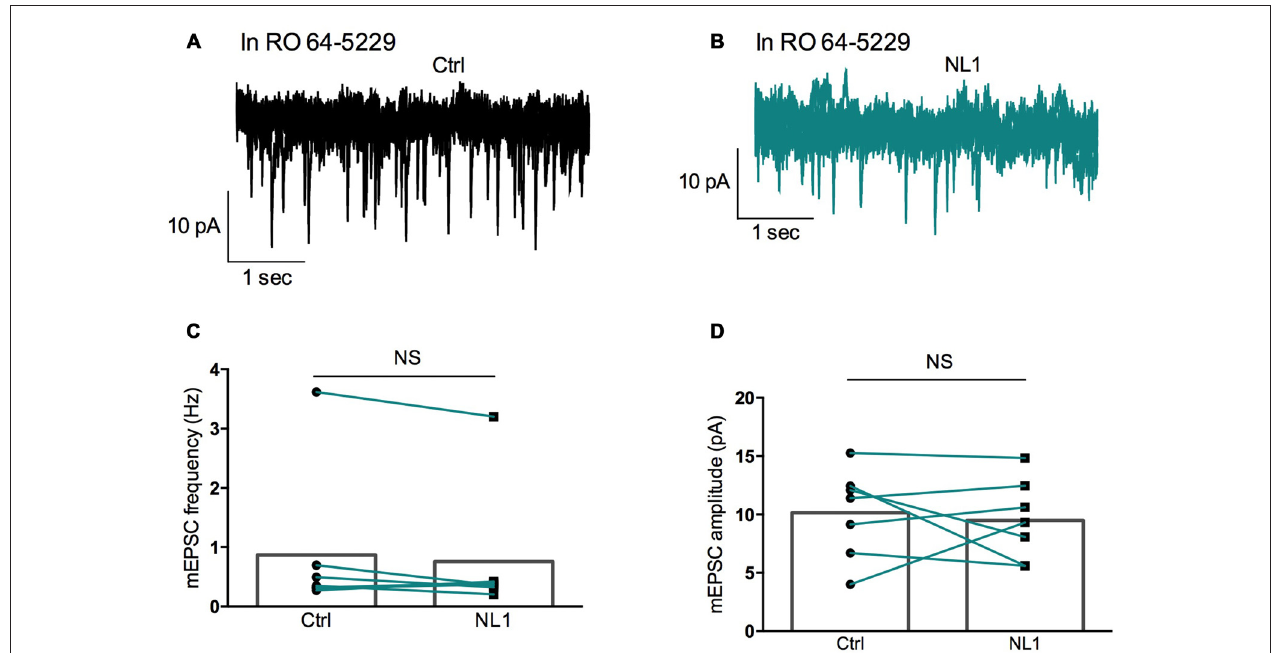
FIGURE 6 | RO 64-5229 reduces the inhibition of mEPSCs induced by ecto-NL1. (A) Example of mEPSC recorded in the presence of RO 64-5229 (50 µ M) in a pyramidal neuron from CA3 region. Five superimposed recordings. (B) Recording from the same neuron after a single puff of ecto-NL1 near the apical dendrite of the recorded neuron (five superimposed traces). (C) Mean frequency of mEPSCs in control conditions and after ecto-NL1 puff. No significant decrease (mean frequency of mEPSCs in control conditions: 0.87 ± 0.5 Hz; after ecto-NL1: 0.77 ± 0.41 Hz; n = 7 cells; p = 0.30, Wilcoxon matched-pairs signed-rank test). (D) Mean amplitude of mEPSCs in control conditions and after ecto-NL1 puff. No significant change (mean amplitude of mEPSCs in control conditions: 10.15 ± 1.44 pA; after ecto-NL1: 9.49 ± 1.30 Hz; n = 7 cells; p = 0.81, Wilcoxon matched-pairs signed rank test). Bars show the mean values and lines correspond to individual pairs of